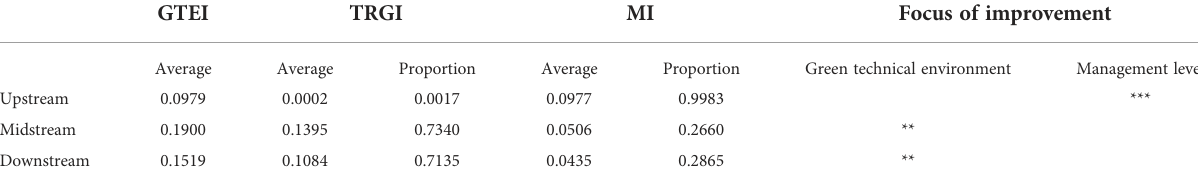
TABLE 4 Decomposition of GTEI values for each link of the industry